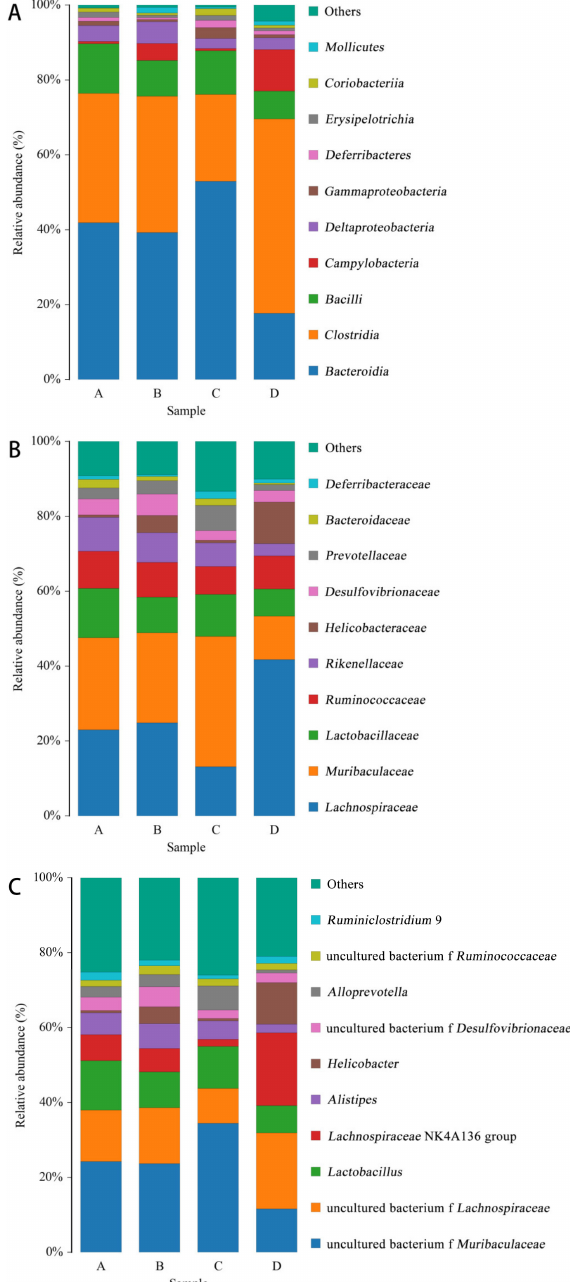
Figure 8. Species distribution histogram. Note: A: CON group, B: L.S group, C: E.coli group, D: L.S + E. coli group. ( A ): class level. ( B ): family level. ( C ): genus